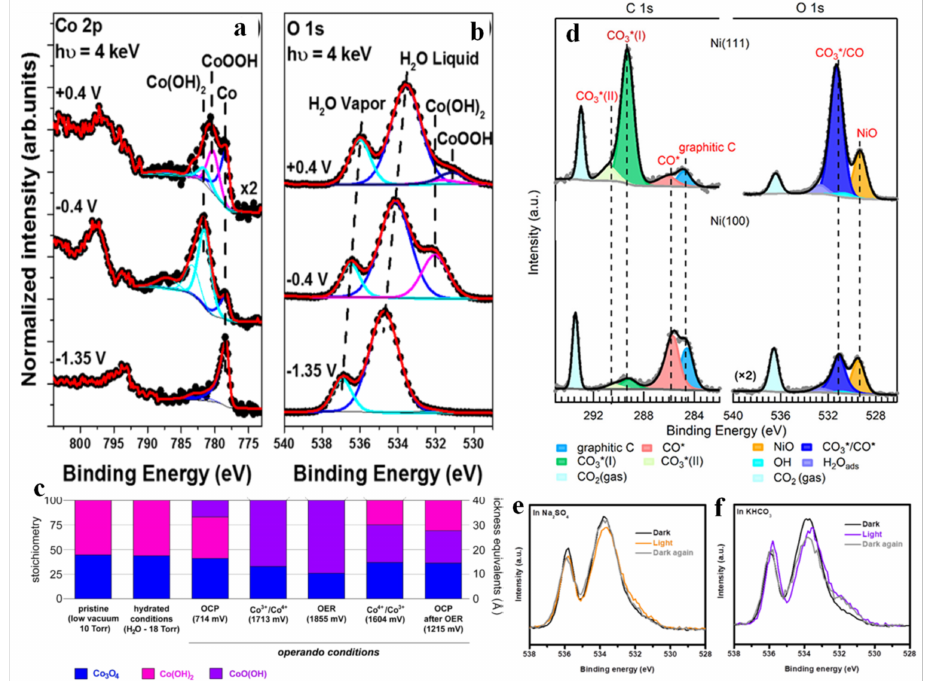
Figure 11. Co 2p ( a ) and O 1s ( b ) spectra using the operando “dip and pull” method collected at − 1.35, − 0.4 and +0.4 V versus Ag/AgCl at h υ = 4 keV in 0.1 M KOH. Adapted with permission from ref. [137]. Copyright 2017 American Chemical Society. Evolution of the surface stoichiometry and structure of the biphasic catalyst as a function of the applied potential ( c ). Adapted with permission from ref. [138]. Copyright 2017 American Chemical Society. C 1s spectra on Ni (111) and Ni (100) and the corresponding O 1s spectra ( d ). Adapted with permission from ref. [139]. Copyright 2019 American Chemical Society. O 1s spectra of Cu 2 O in the dark, under illumination and in the dark again at OCP in 0.1 M Na2SO4 solution ( e ) and in 0.1 M KHCO 3 solution ( f ). Adapted with permission from ref. [140]. Copyright 2021 Springer